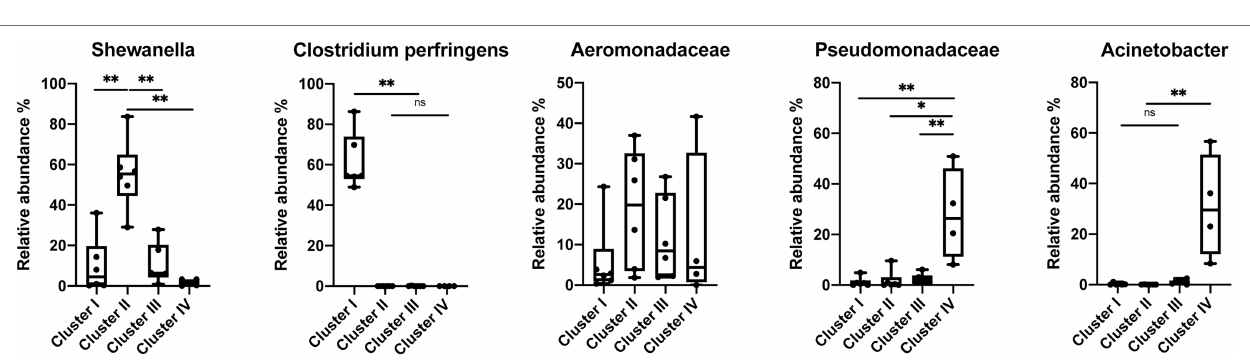
FIGURE 6 | Relative abundance of the most abundant species in the Phasmarhabditis species. Mann–Whitney U-test, * p < 0.05; ** p < 0.01. Boxplots show inter- quartile range, whiskers minimum to